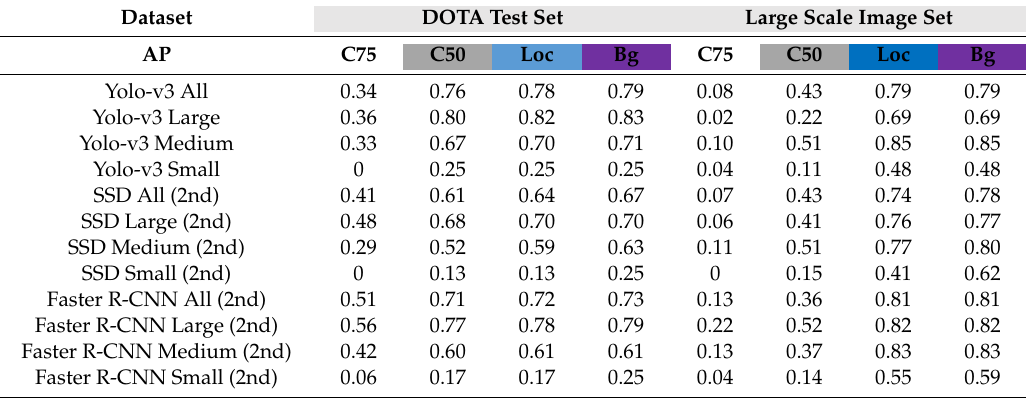
Table 5. Average precision (AP) metrics of all test sets for all networks according to COCO metric